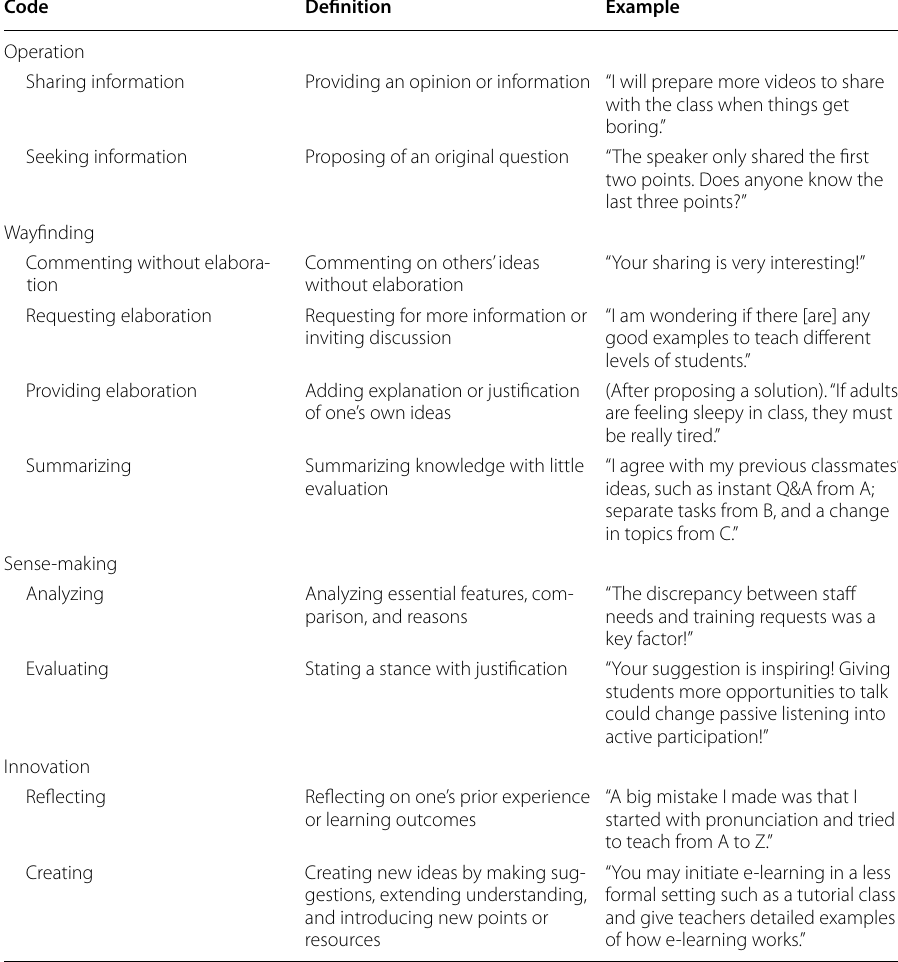
Table 3 Analytical framework of cognitive engagement